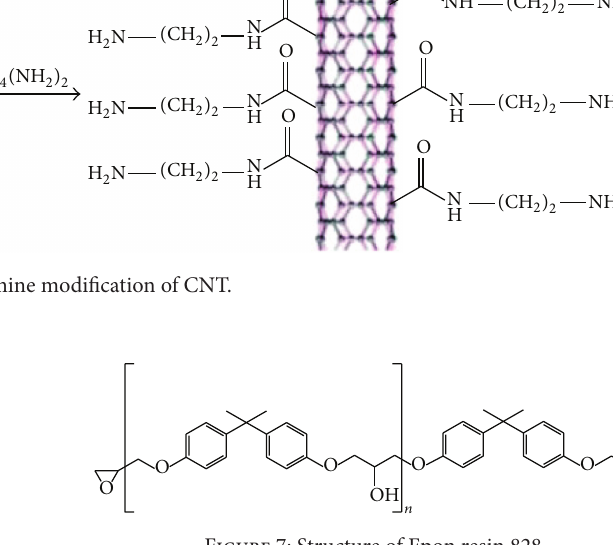
Figure 7: Structure of Epon resin